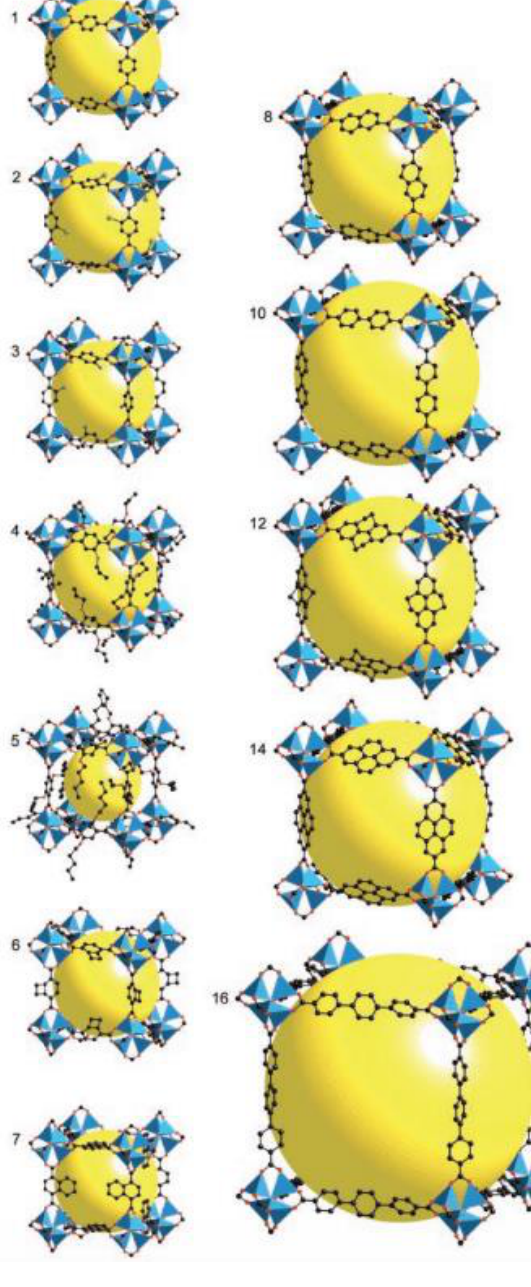
Figure 1. Structures of IR-MOF family (1–16) [88]. Adapted from ref. [80] with